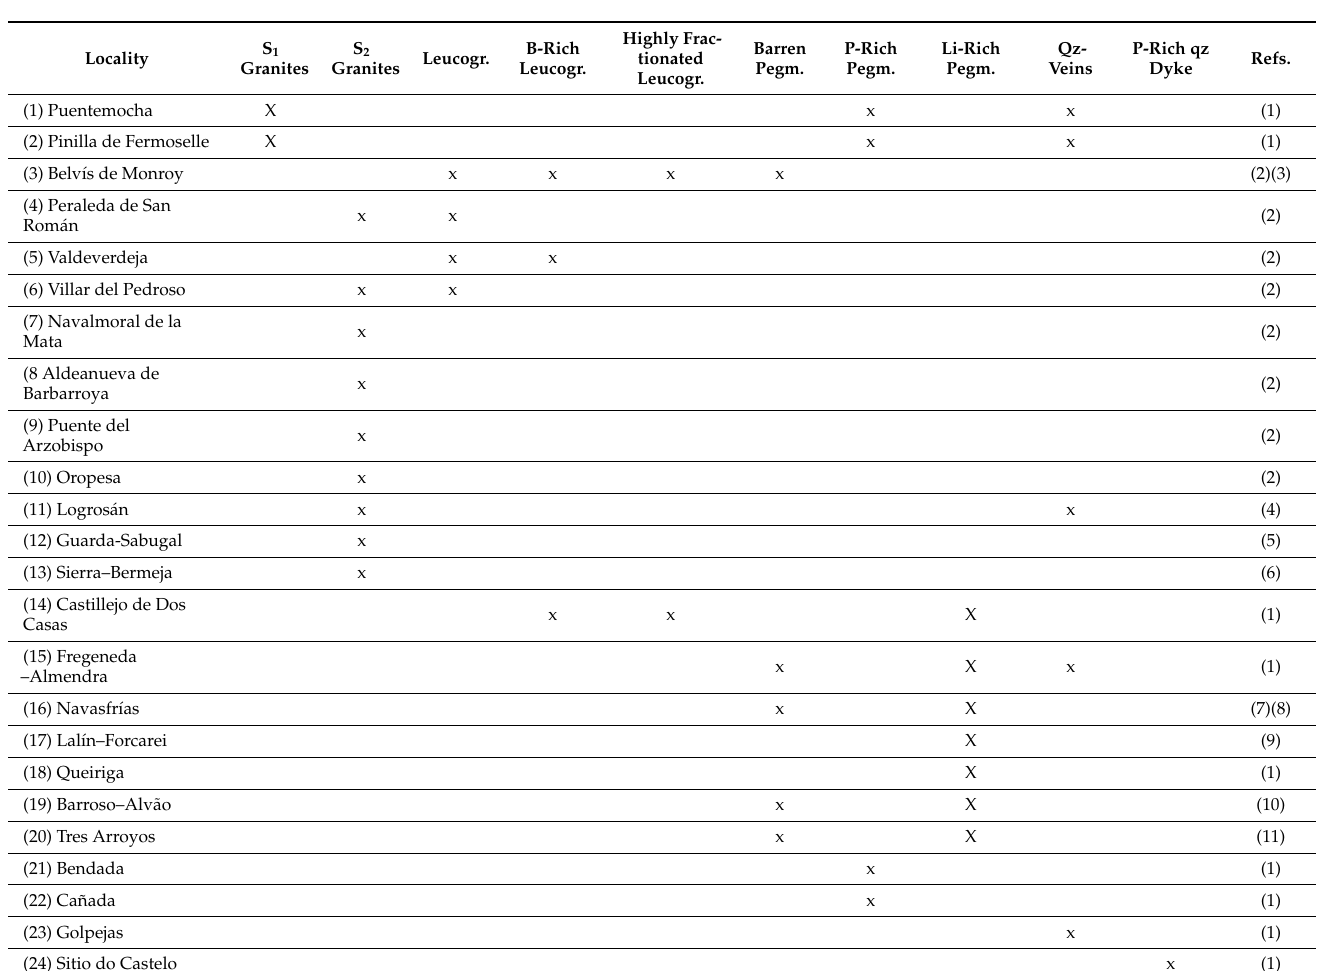
Table 1. Localities and lithologies from which apatite was selected and analyzed for this study. Numbers in the left column correspond to those in the map of Figure 1. References: (1) this